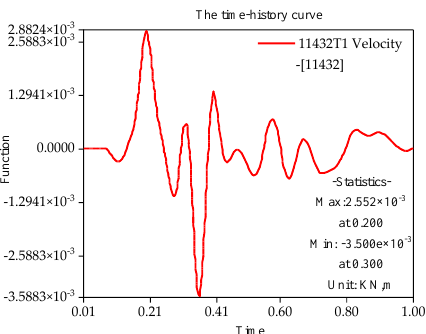
Figure 12. T1 Vibration curve on the basement of perilous rock.